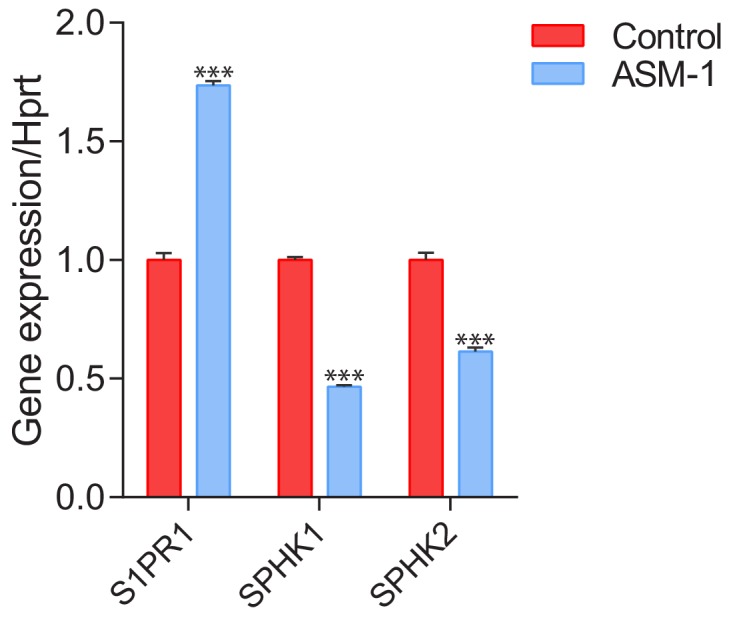
Transcript levels of sphingosine-1-phosphate receptor 1 (S1PR1) and sphingosine kinases 1 (SPHK1) and 2 (SPHK2) in ASM-deficient fibroblasts.Transcript levels of S1PR1, SPHK1 and SPHK2 were measured by qPCR and depicted as mean ± s.e.m, n = 3. T-test p-values ***p<0.001.